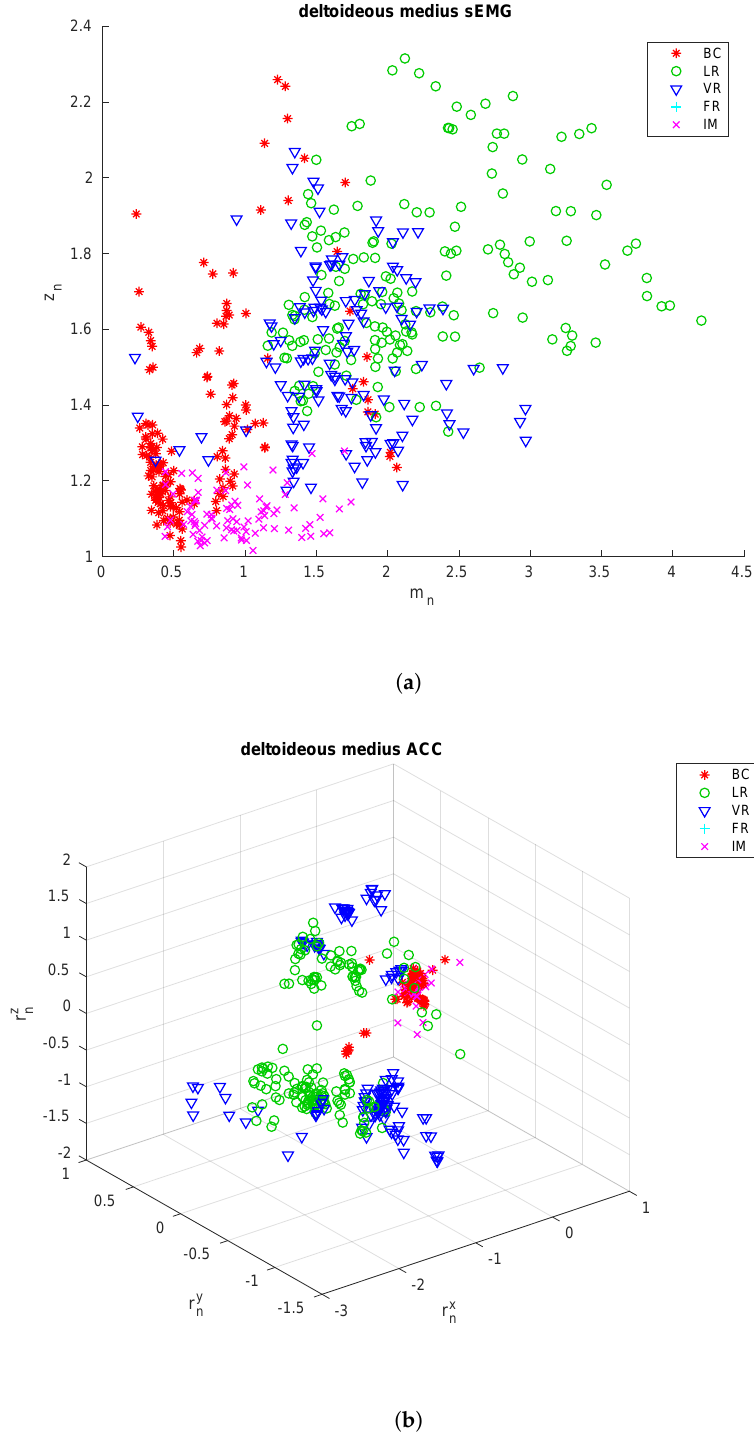
Figure 4. Deltoideus medius signals. Extracted from the sEMG signal ( a ) and the acceleration signals ( b ) from the sensors applied to the deltoideus medius of all the subjects included in the training and testing